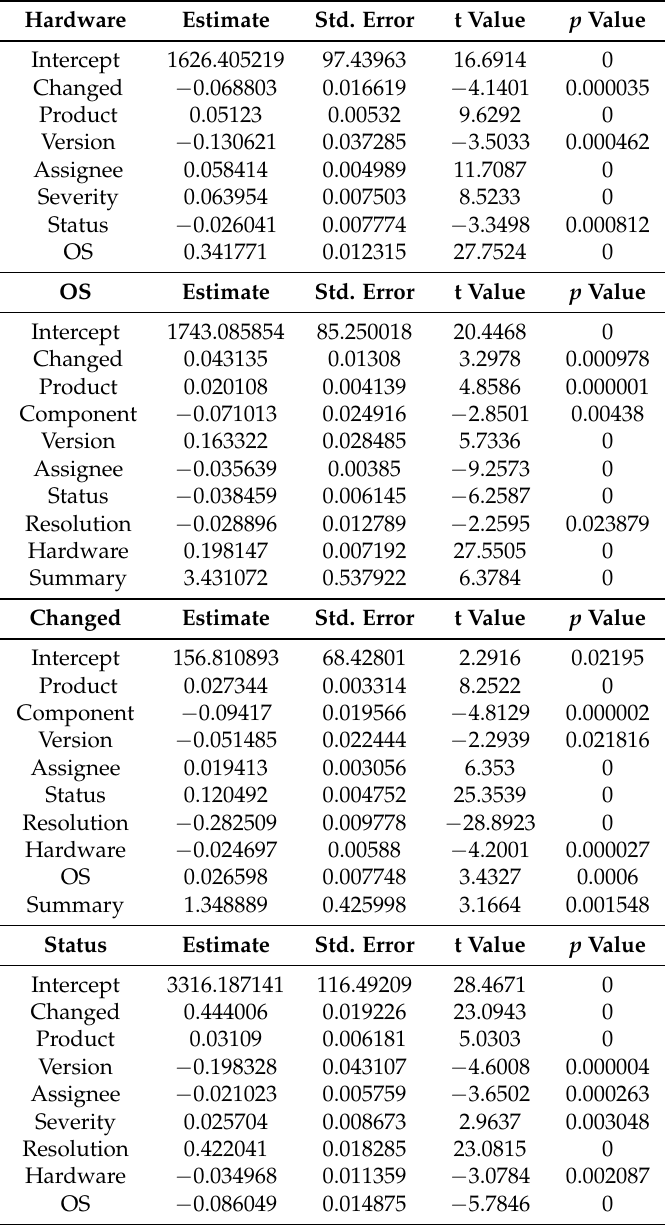
Table 4. The estimation results by backward stepwise selection method in cases Hardware, OS, Changed, and Status as objective variables.